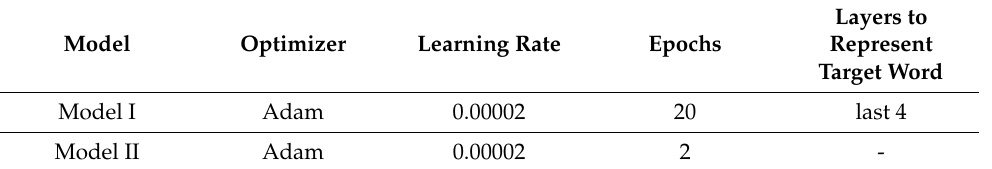
Table 7. The hyperparameter configurations for Model I and Model